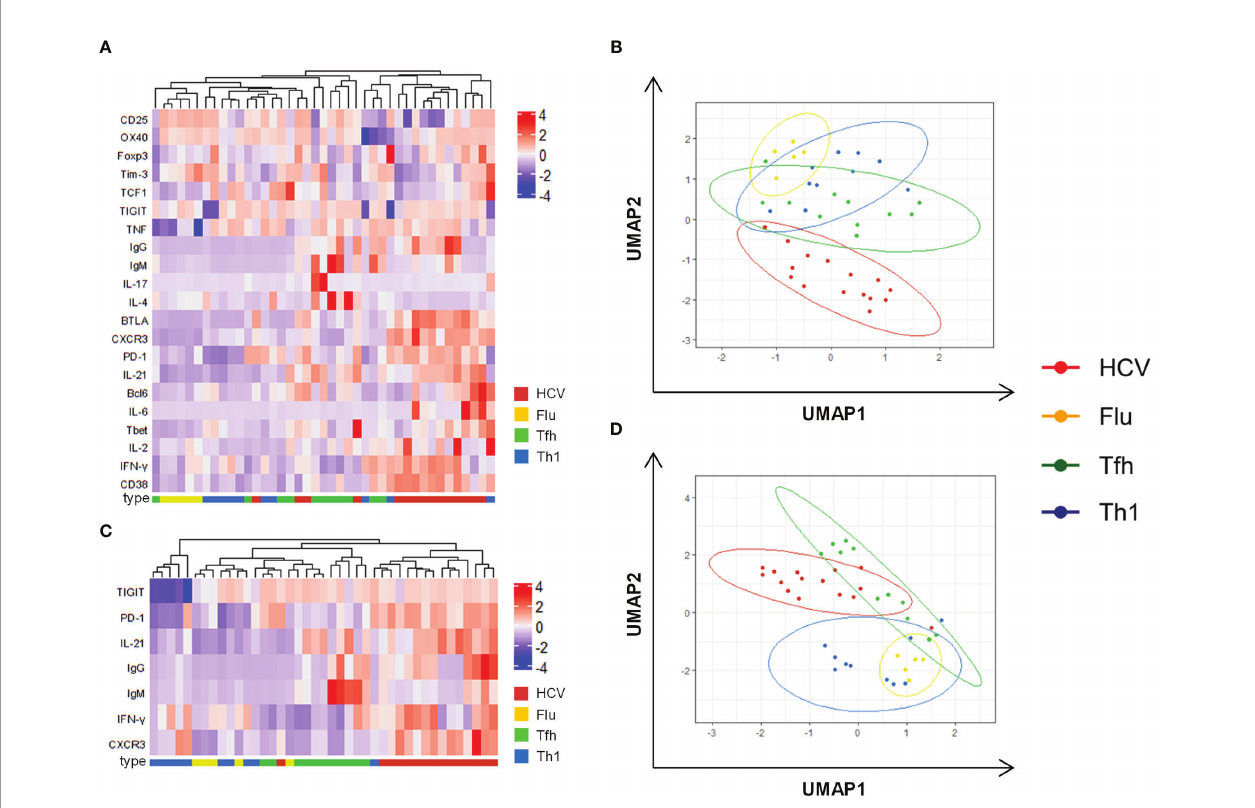
FIGURE 3 | Combined analysis con fi rms unique Th1-biased Tfh characteristics of HCV clones. (A) Heatmap with unbiased clustering analysis (rows and columns) of the clone types including all analyzed parameters. (B) Corresponding UMAP analysis of data in (A) . (C) Heatmap with unbiased clustering analysis (rows and columns) of the clone types including parameters that are able to discriminate between Tfh and Th1 clones (Supplementary Figure 5) . (D) Corresponding UMAP analysis of data in (C) . (A – D) Cytokine production after stimulation with PMA/Iono was used for these analyses. Only clones with a complete analysis of all parameters were included (n = 15 HCV, 5 Flu, 11 Tfh, 10 Th1 clones). (B, D) Each symbol represents one CD4 T cell clone of the indicated